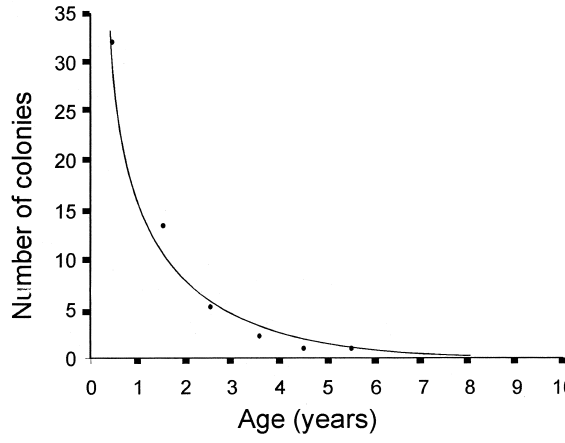
F IG . 1. – Population size structure of Corallium rubrum : the dis- tribution of colonies (X dm -2 ) into size classes (a) is reported. a Points have been fitted by the following power curve: X